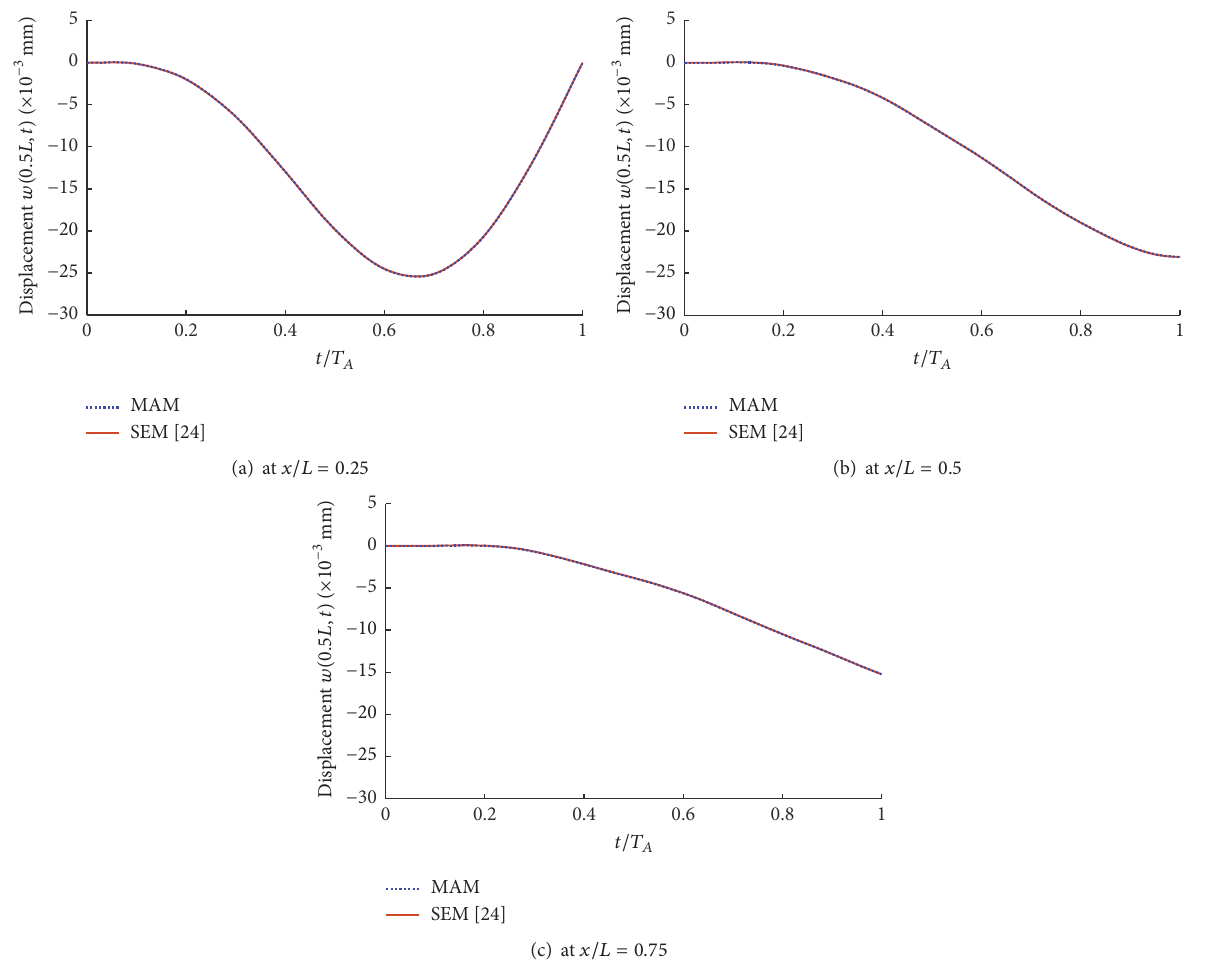
Figure 11: Comparison of the transverse displacements 𝑤(𝑥, 𝑡) obtained by the present MAM and the SEM in [24] at 𝑥/𝐿 = 0.5 of a simply supported Timoshenko beam subjected to a point transverse force moving at three different constant speeds V 𝑓 : (a) V 𝑓 = 0.5 V cr ; (b) V 𝑓 = V cr ; (c) V 𝑓 = 1.5 V cr